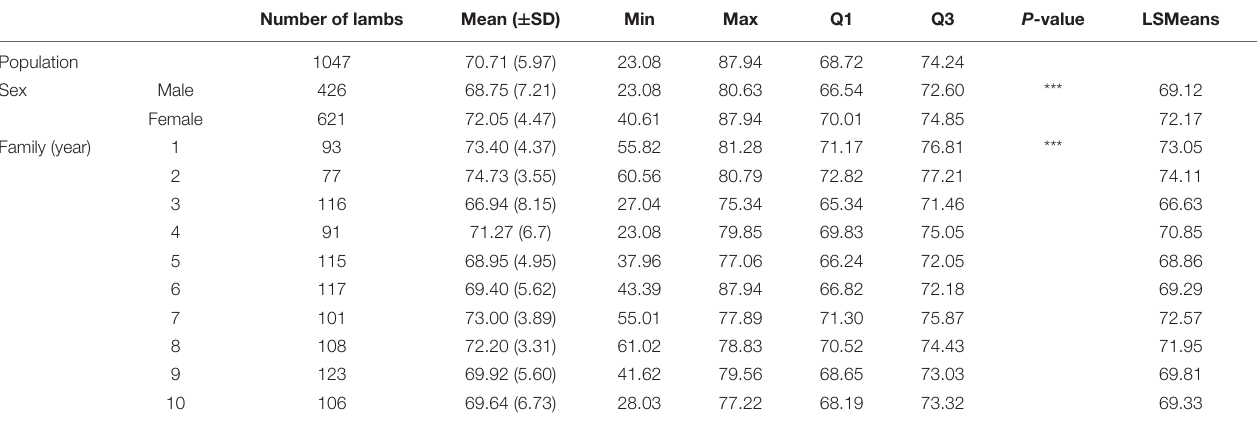
TABLE 1 | Number of records, mean ( ± SD), minimum, maximum, quartiles, and least squares means for global DNA methylation rate in the whole population and for each sex and each family.